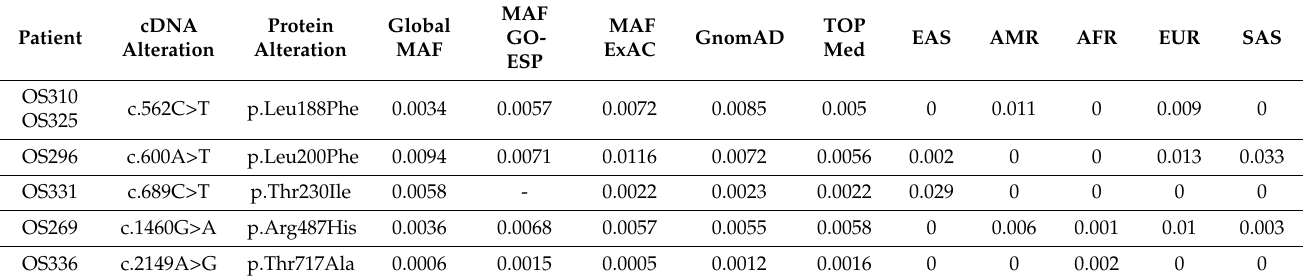
Table 3. Frequencies of the SPECC1L variants